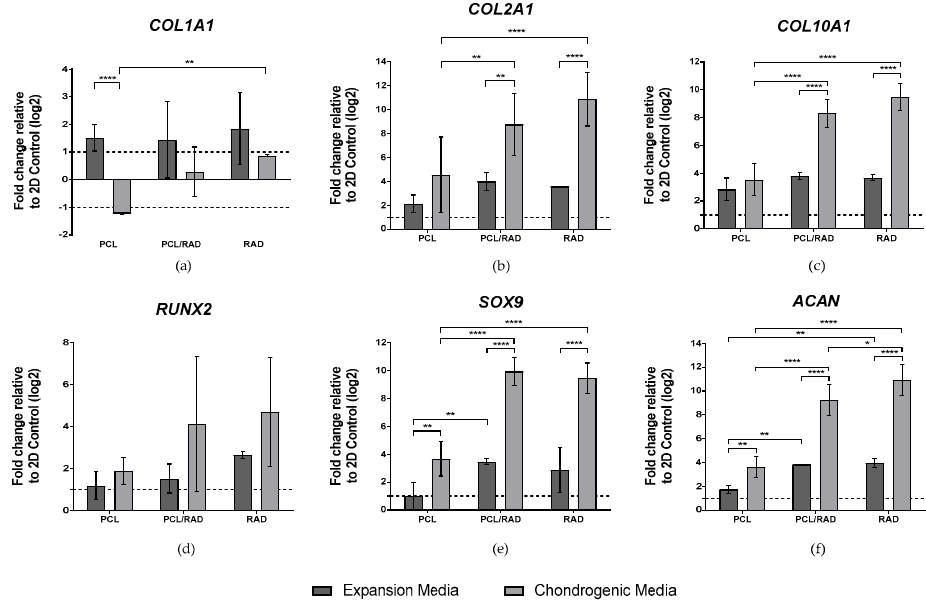
Figure 5. Gene expression of chondrogenic and hypertrophic markers for PCL, PCL / RAD and RAD samples under expansion or chondrogenic media for 30 days. ( a ) Collagen type I (COL1A1), ( b ) collagen type II (COL2A1), ( c ) collagen type X (COL10A1), ( d ) RUNX2, ( e ) SOX9 and ( f ) aggrecan (ACAN) were determined through qRT-PCR. Ct values relative human beta actin (ACTB) were obtained and reported as fold increase ( ΔΔ Ct) relative to 2D cultures (Statistical differences are indicated as: * p < 0.05, ** p < 0.01, *** p < 0.001 and **** p < 0.0001, two-way ANOVA). n = 3. Protein analysis was performed to correlate gene expression results with protein production. We